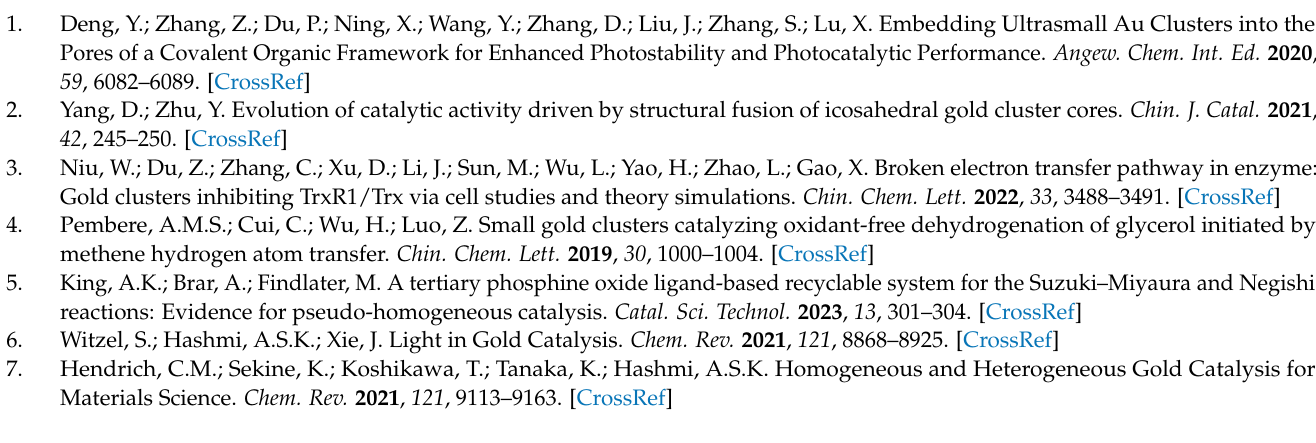
of the lowest-energy structures of Au n ( n = 1–6) based on theory at the CAM-B3LYP/aug-cc-pVDZ- PP level. Figure S2. Geometrical optimizations of the lowest-energy structures of Au n Si ( n = 1–5) based on theory at the CAM-B3LYP/aug-cc-pVDZ-PP level. Figure S3. Optimized lowest-energy geometries of CO adsorbed with Au n ( n = 1–6) and the corresponding adsorption energies at the CAM-B3LYP/aug-cc-pVDZ-PP level (in kcal/mol). Figure S4. CO adsorption on Au atoms of Au n ( n = 1–2) cluster structures and the corresponding adsorption energies at the CAM-B3LYP/aug-cc- pVDZ-PP level (in kcal/mol). Figure S5. Potential energy profile of CO oxidation on Au atoms at the CAM-B3LYP/aug-cc-pVDZ-PP level. (a) Oxidation of CO on the Au cluster and (b) oxidation of CO on the OAu cluster (in kcal/mol). Figure S6. Potential energy profile of CO oxidation on Au 2 atoms at the CAM-B3LYP/aug-cc-pVDZ-PP level. (a) Oxidation of CO on the Au 2 cluster and (b) oxidation of CO on the OAu 2 cluster (in kcal/mol). Figure S7. Potential energy profile of CO oxidation on Au 3 atoms at the CAM-B3LYP/aug-cc-pVDZ-PP level. (a) Oxidation of CO on the Au 3 cluster and (b) oxidation of CO on the OAu 3 cluster (in kcal/mol). Figure S8. Potential energy profile of CO oxidation on Au 4 atoms at the CAM-B3LYP/aug-cc-pVDZ-PP level. (a) Oxidation of CO on the Au 4 cluster and (b) oxidation of CO on the OAu 4 cluster (in kcal/mol). Figure S9. Potential energy profile of CO oxidation on Au 5 atoms at the CAM-B3LYP/aug-cc-pVDZ-PP level. (a) Oxidation of CO on the Au 5 cluster and (b) oxidation of CO on the OAu 5 cluster (in kcal/mol). Figure S10. Potential energy profile of CO oxidation on Au 6 atoms at the CAM-B3LYP/aug-cc-pVDZ-PP level. (a) Oxidation of CO on the Au 6 cluster and (b) oxidation of CO on the OAu 6 cluster (in kcal/mol). Figure S11. The structure and energy of various substances in the oxidation pathway for CO on AuSi (in kcal/mol). Figure S12. The structure and energy of various substances in the oxidation pathway for CO on Au 2 Si (in kcal/mol). Figure S13. The structure and energy of various substances in the oxidation pathway for CO on Au 3 Si (in kcal/mol). Figure S14. The structure and energy of various substances in the oxidation pathway for CO on Au 4 Si (in kcal/mol). Figure S15. The structure and energy of various substances in the oxidation pathway for CO on Au 5 Si (in